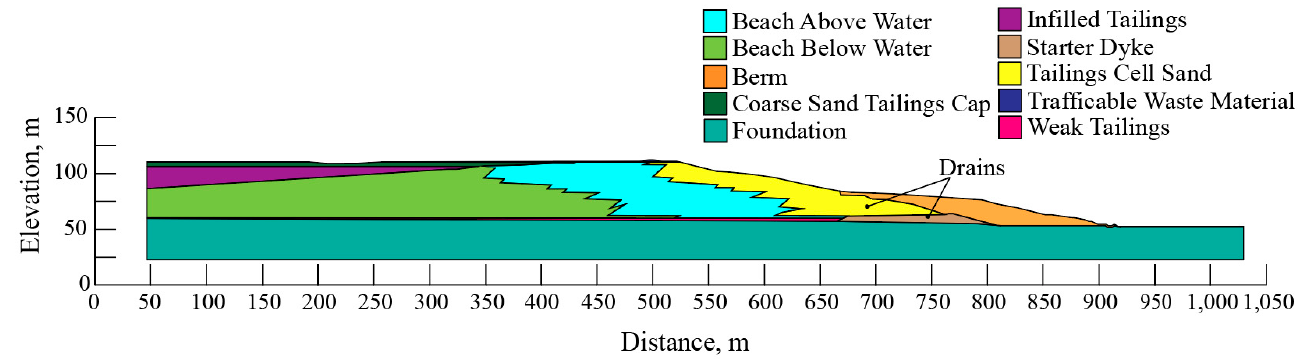
Figure 2. Case study cross-section.